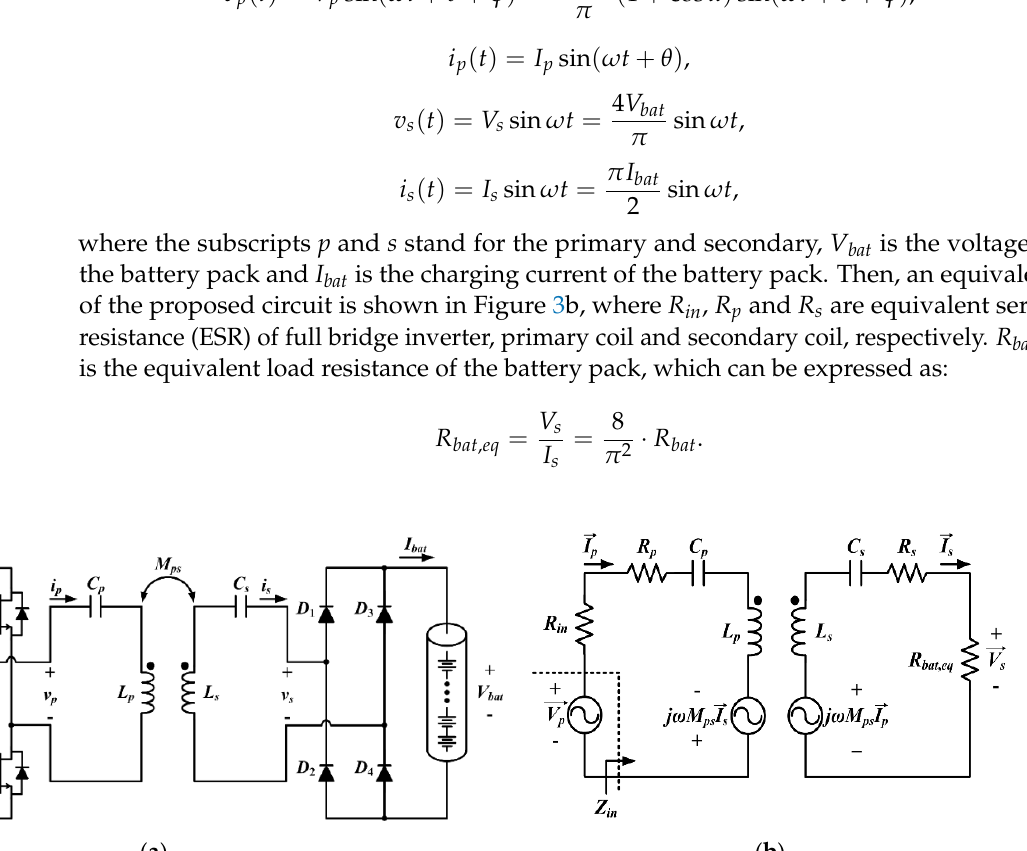
Figure 4. The gate signals and output voltage waveform of the full bridge inverter.